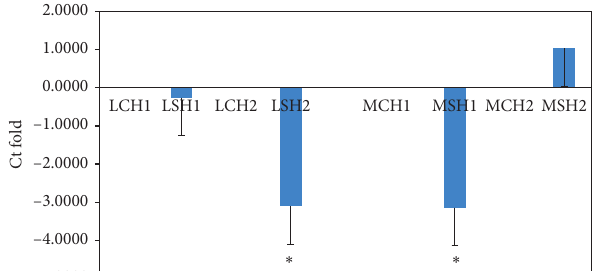
Figure 4: Comparison of relative fold change in the gene ex- pression of ghrelin receptor (GHR) in liver (L) and magnum (M) tissues of Nicobari chicken after 10d (CH1 and SH1) and 20d (CH2 and SH2) of the experiment. C: control; S: supplemented with FYC at 700mg/kg. ∗ P < 0 . 05 N � 4. From 21 to 23 weeks of age, the CH and SH group birds were exposed to 39 ° C for 4h under controlled conditions.